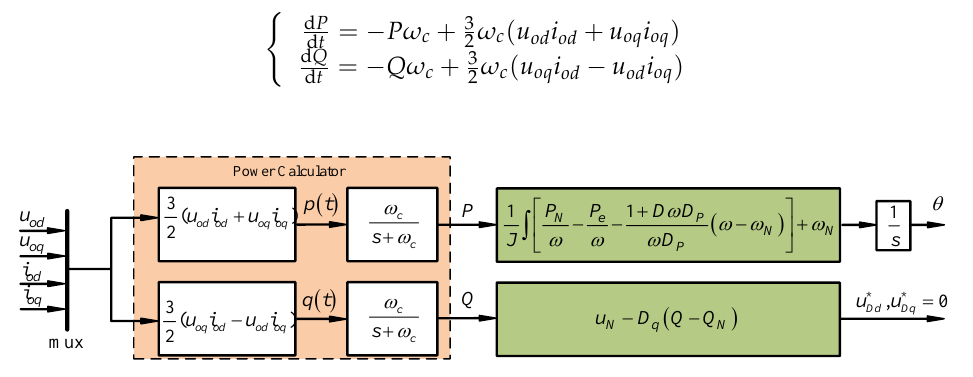
Figure 6. Power calculator.